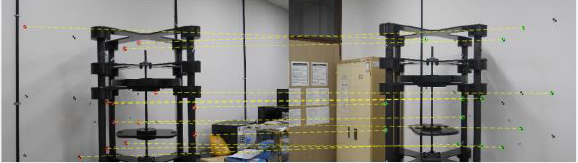
Figure 6. Matching points in frames from Camera A and